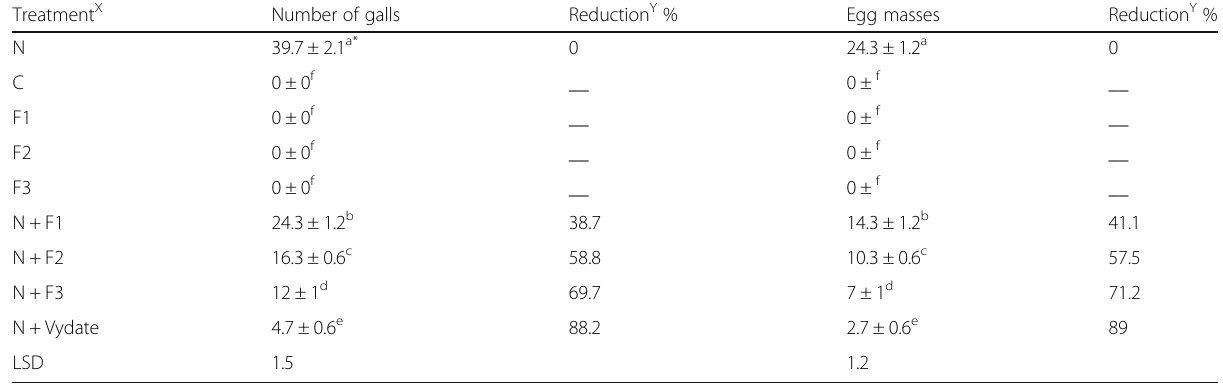
Table 3 Effect of formulated Bacillus subtilis isolate B10 on number of galls and egg masses of Meloidogyne incognita occurrence in the roots of tomato plants Treatment X Number of